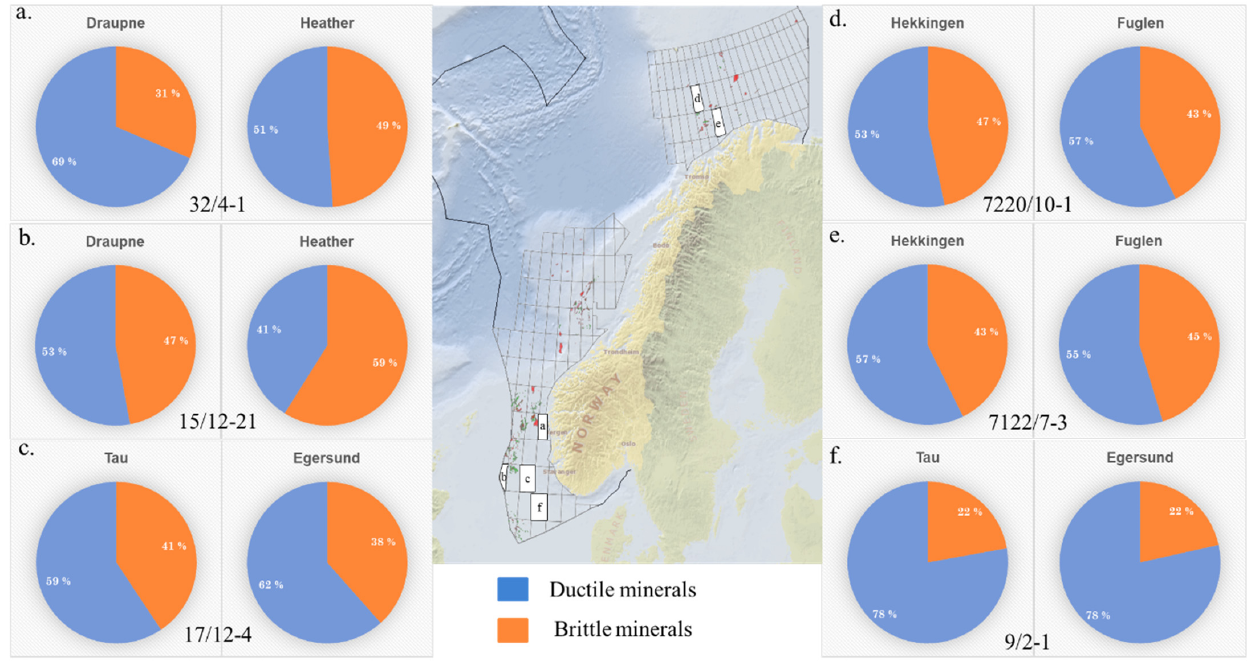
Figure 4. The ductile (i.e., clay and TOC) and brittle (i.e., quartz, feldspar, carbonate and pyrite) mineral percentages of Upper Jurassic caprock in different sub-basins in Norwegian Continental Shelf: ( a ) Draupne and Heather formations from the northern North Sea, ( b ) Draupne and Heather formations from South Vikings Graben, ( c , f ) Tau and Egersund formations from Norwegian–Danish Basin, and ( d , e ) Hekkingen and Fuglen formations from SW Barents Sea. The map in the middle represents the block location of the wells studied here.